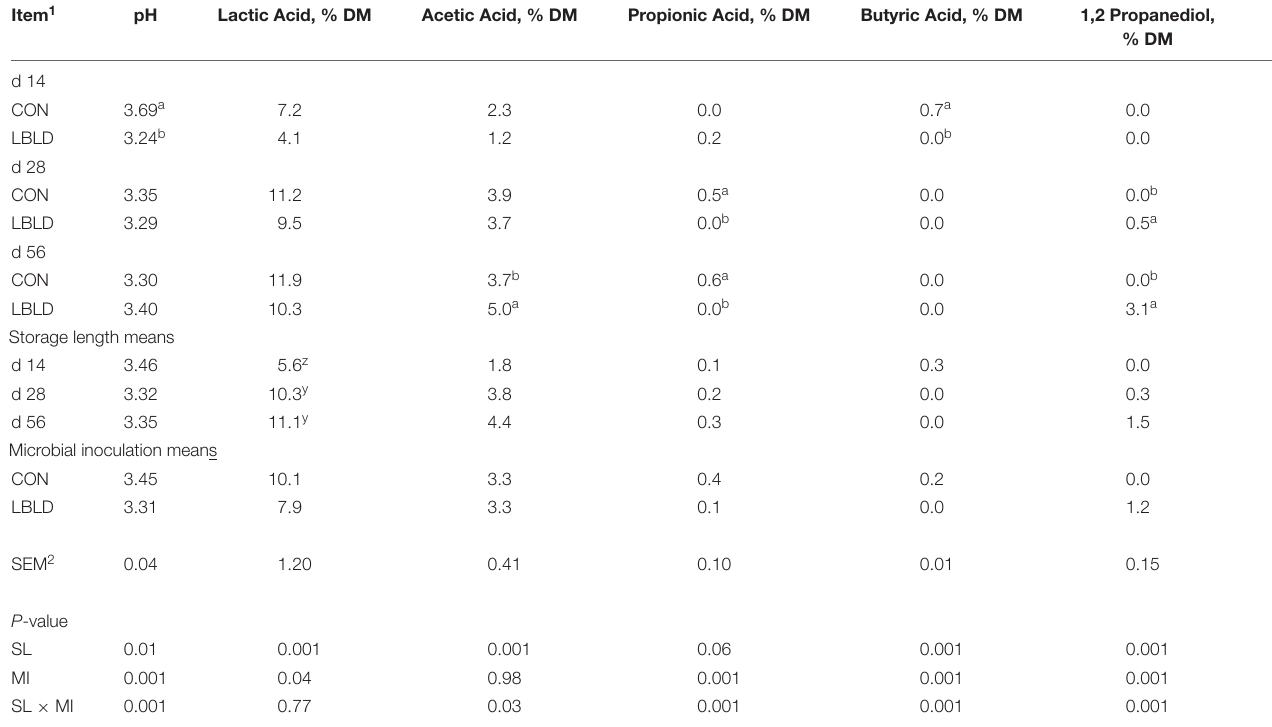
TABLE 6 | Effect of microbial inoculation and storage length on the fermentation profile of whole-plant sweet sorghum silage in experiment 2. Item